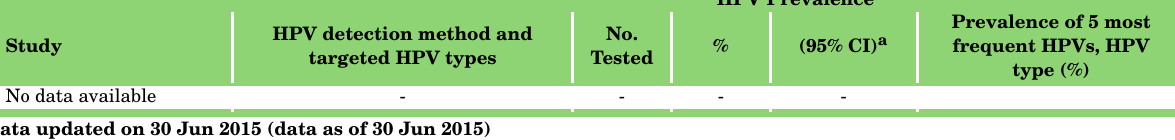
Table 25: Studies on HPV prevalence among anal cancer cases in Peru (male and female)